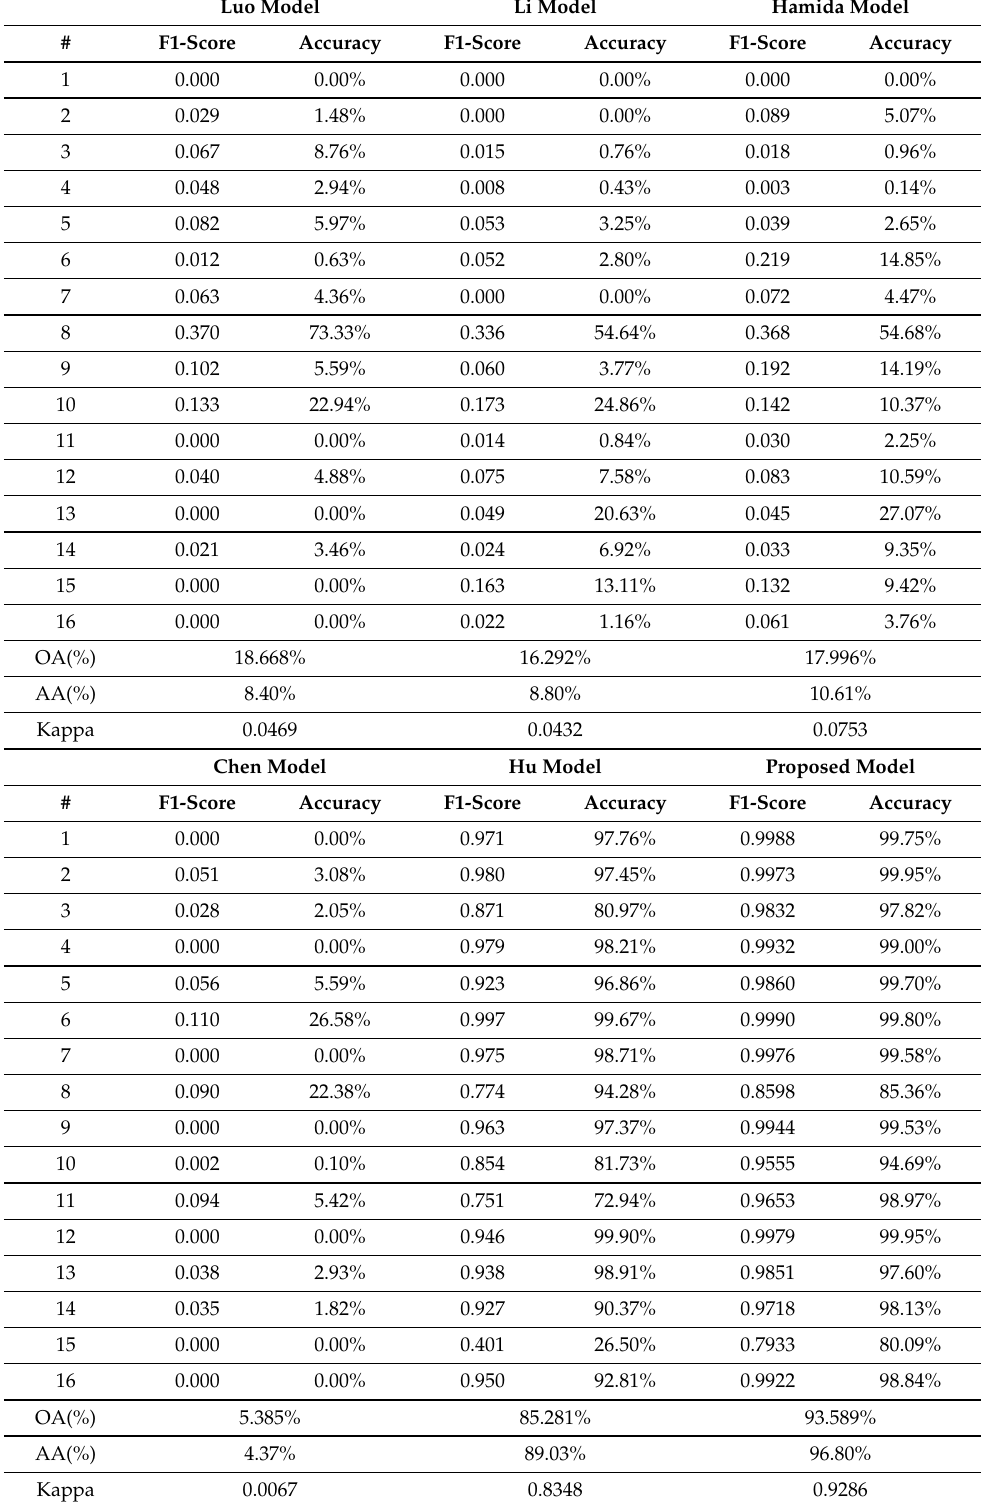
Table 14. Classification results of the Salinas dataset to which random spatial information is not applied for training and random spatial information to